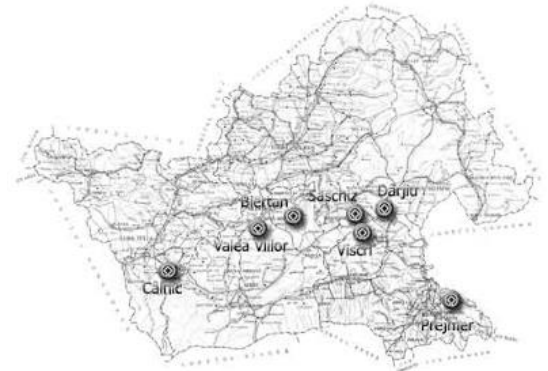
Figure 2. Enclaves listed by UNESCO in Transylvania